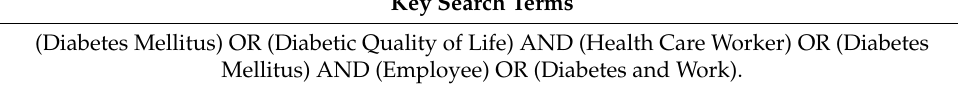
Table 2. Key Search Terms.